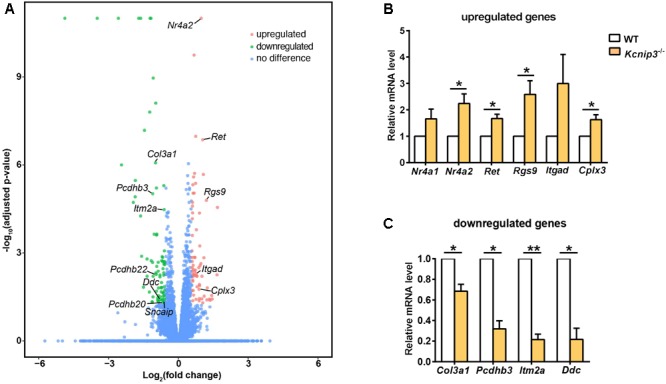
(A) Volcano plots illustrating log10(adjusted p-value) in relation to the log2(fold change) for the differentially expressed genes in Kcnip3-/- rats compared to wild-type rats. Genes that passed the significance threshold (FDR < 0.05) and the expression cut-off log2(fold change) > 0.58 are colored red (upregulated, fold change > 1.5) or green (downregulated, fold change < 0.67), while genes outside this range are colored blue. (B) qPCR analysis of upregulated genes in the forebrain cortex of wild-type (WT) and Kcnip3-/- rats. n = 4–5, ∗p < 0.05, paired t-test. (C) qPCR analysis of downregulated genes in the forebrain cortex of WT and Kcnip3-/- rats. n = 3, ∗p < 0.05, ∗∗p < 0.01, paired t-test.